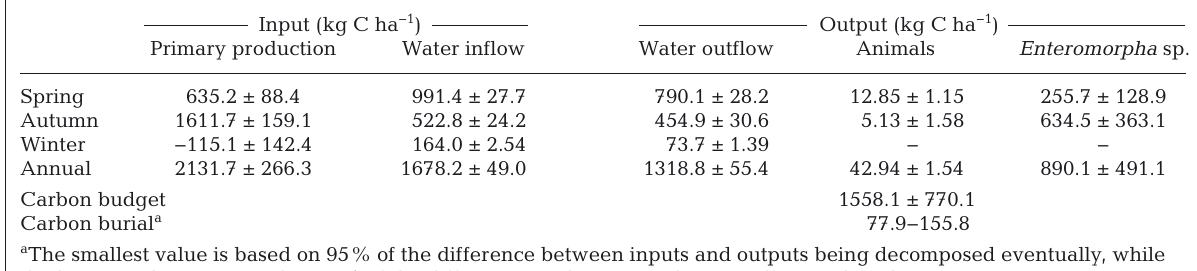
a The smallest value is based on 95% of the difference between inputs and outputs being decomposed eventually, while the largest value assumes that 90% of the differences is decomposed eventually (Boyd et al. 2010)